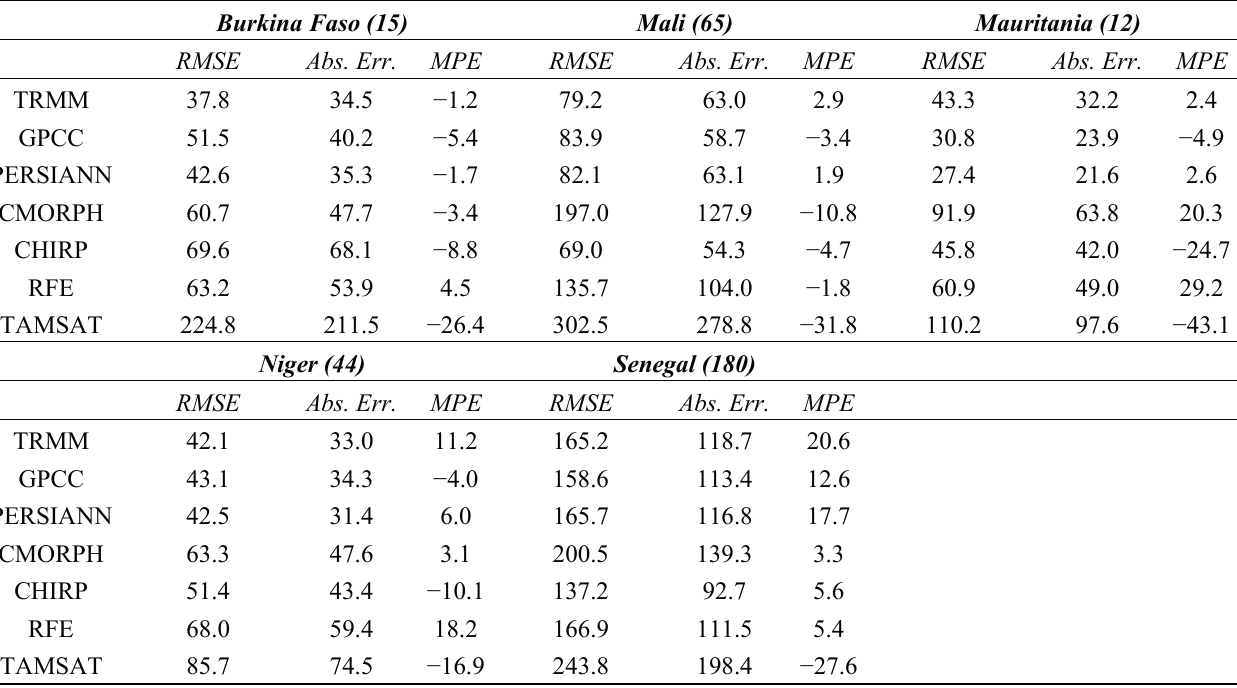
Table 3. Statistical indicators of Satellite-derived dataset versus rain gauge stations across nine validation countries. Numbers in parentheses in the first row refer to the number of rain gauge station employed for each